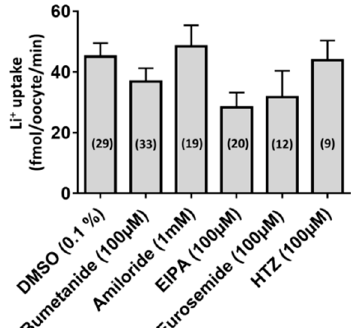
Figure 3. Pharmacology of the Li + uptake in Xenopus oocytes heterologously expressing aeCCC2. Rates of Li + uptake was measured in Xenopus oocytes 2–3 days after injection with aeCCC2 cRNA (80 ng) or H 2 O (80 nL). Inhibitor concentrations are indicated on the x-axis. DMSO (0.1%) served as the control. Values are means ± SEM based on the number of oocytes in parentheses. A one-way ANOVA was performed, which was not significant ( p > 0.05 ). EIPA: ethyl isopropyl amiloride; HTZ: hydrochlorothiazide.